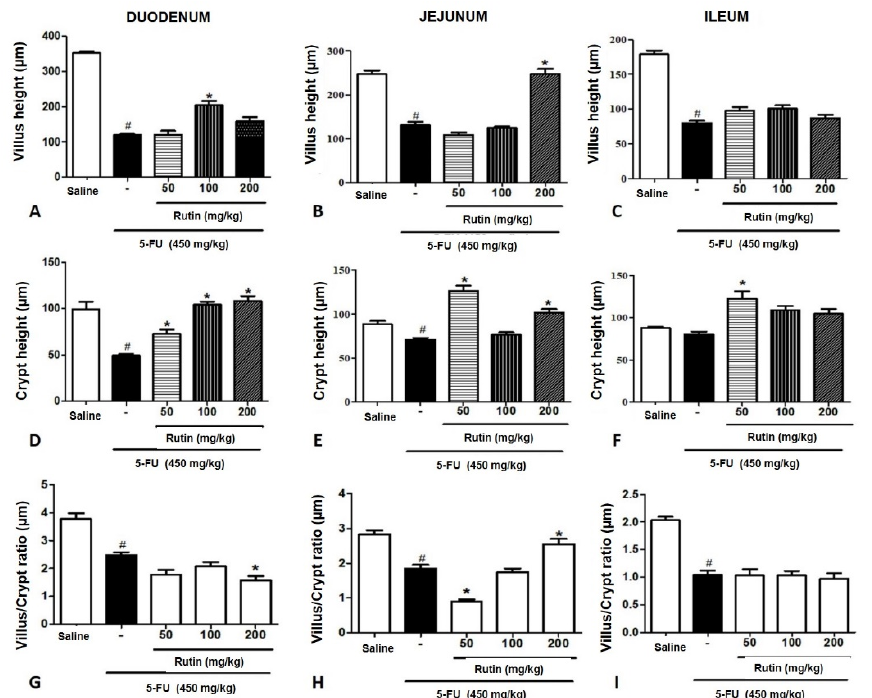
Figure 5. Morphometric analyses of the mice intestinal segments following 5-FU-induced intestinal mucositis. Experimental groups: Saline, 5-FU, RUT-50, RUT-100, and RUT 200 mg / kg. ( A – C ): Villi height in the duodenal, jejunal, and ileal segments, respectively. ( D – F ): Crypt depth of the duodenal, jejunal, and ileal segments, respectively. ( G – I ): Villus / crypt ratio of the duodenal, jejunal, and ileal segments, respectively. Values are expressed as mean ± SEM. Statistical analysis was performed using the one-way analysis of variance, followed by Tukey’s test. # p < 0.05 vs. saline group and * p < 0.05 vs. group 5-FU. Villus height ( µ m), Crypt height ( µ m), Villus / Crypt ratio ( µ m). 5-FU, 5-fluorouracil; RUT, rutin .